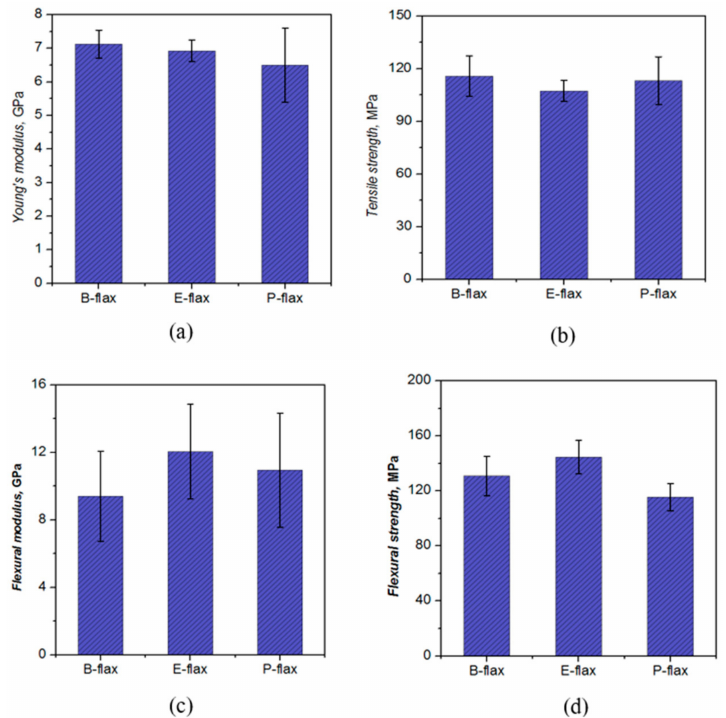
Figure 7. Mechanical properties of the composites using three resin systems ( a ) Young’s modulus, ( b ) tensile strength, ( c ) flexural modulus and ( d ) flexural